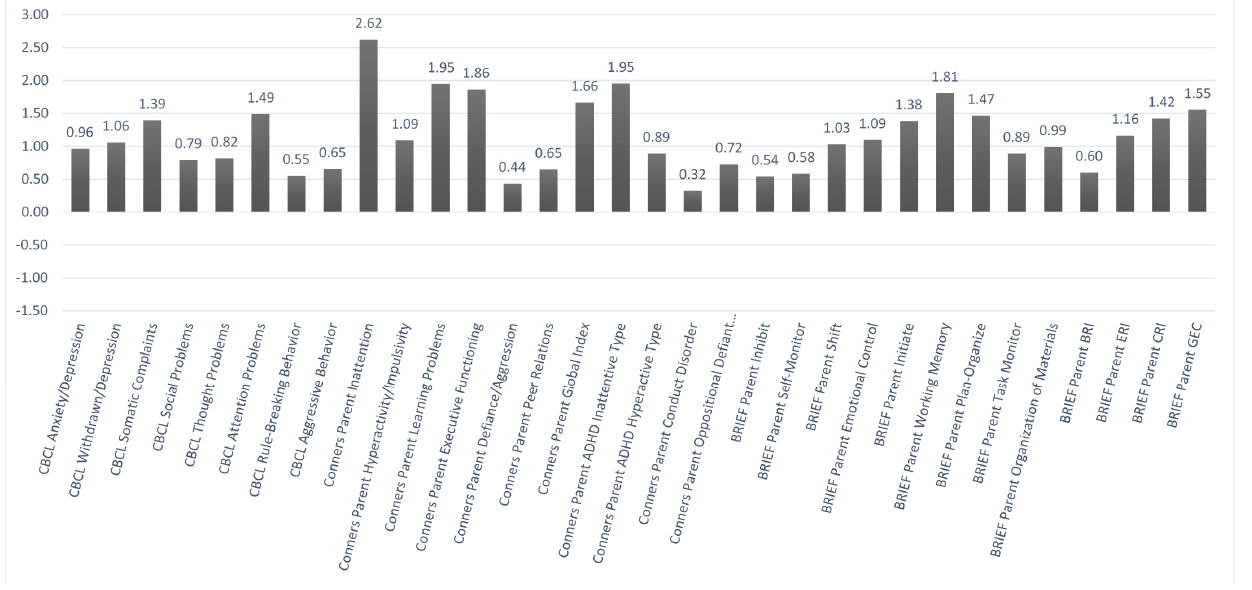
Figure 3. Behavioral Parent Report Baseline Data. n = 17. The y-axis is based on z -scores (M = 0, SD = +/- 1). Higher scores indicate the reporting of greater problems. Child Behavior Checklist (CBCL); Behavior Rating Inventory of Executive Functioning (BRIEF); Behavior Regulation Index (BRI); Emotion Regulation Index (ERI); Cognitive Regulation Index (CRI); Global Executive Composite (GEC).